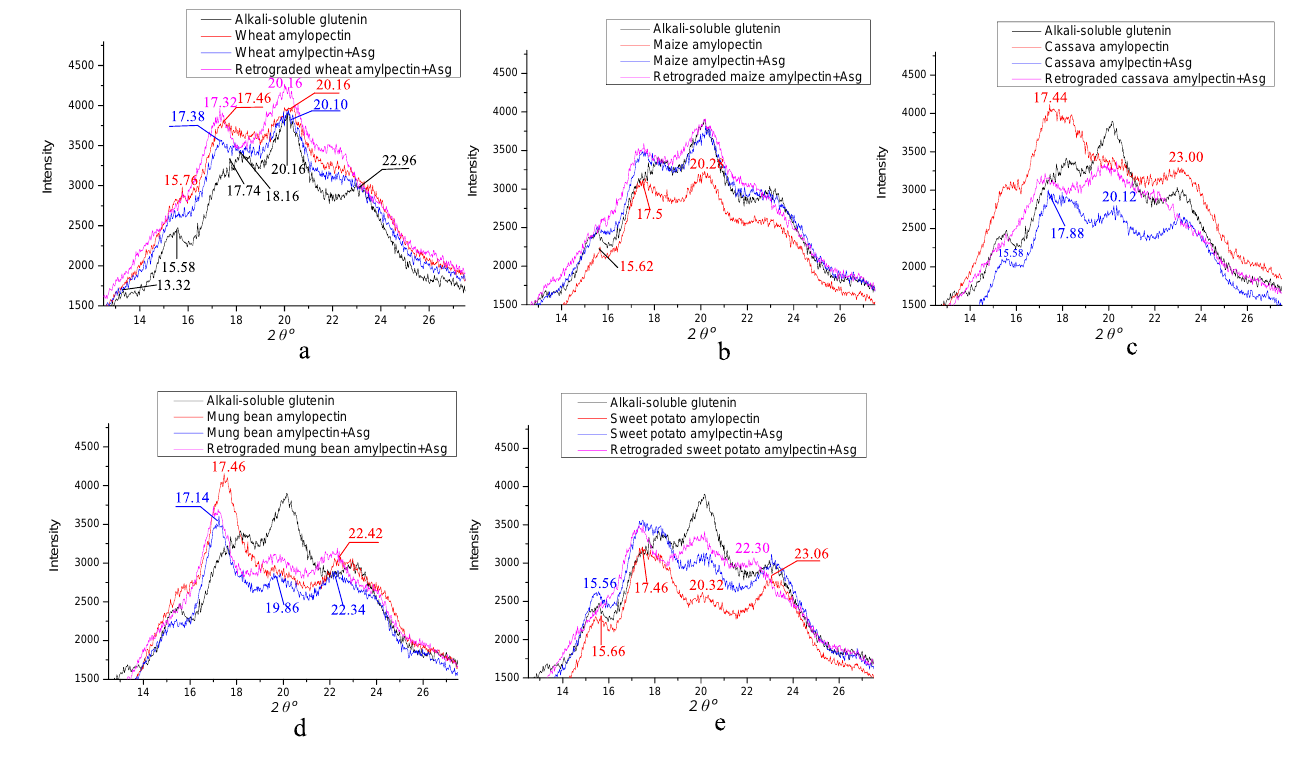
Figure 3. X-ray diffraction of different amylopectins mixed with alkali-soluble glutenin before and after retrogradation. ( a ) wheat amylopectin group, ( b ) maize amylopectin group, ( c ) cassava amylopectin group, ( d ) mung bean amylopectin group, ( e ) sweet potato amylopectin group. Result for alkali-soluble glutenin in Figure 3a–e is from the same sample, addition of it in every figure is to facilitate comparative analysis.